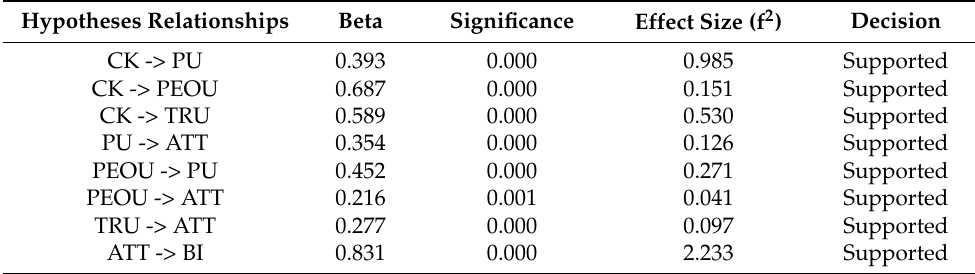
Figure 2. Results of the proposed model. Notes: * p < 0.05, ** p < 0.01, *** p < 0.001; ns = non-significant. Table 6. The summary of the